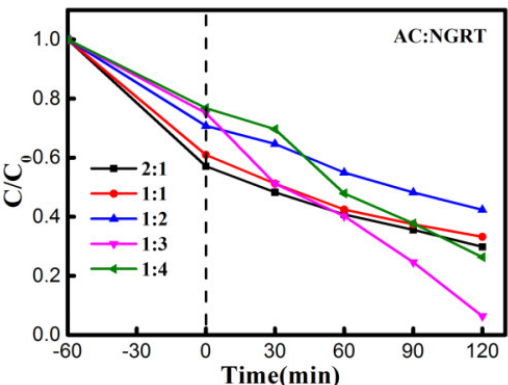
Figure 7. Effect of weight ratios of the NGRT and AC in the NGRT@AC-PSF membrane on photocatalytic degradation of MO under UV irradiation. Conditions: The effective area was 17.34 cm 2 , and the concentration and amount of MO solution were 30 mg/L and 150 mL, respectively.